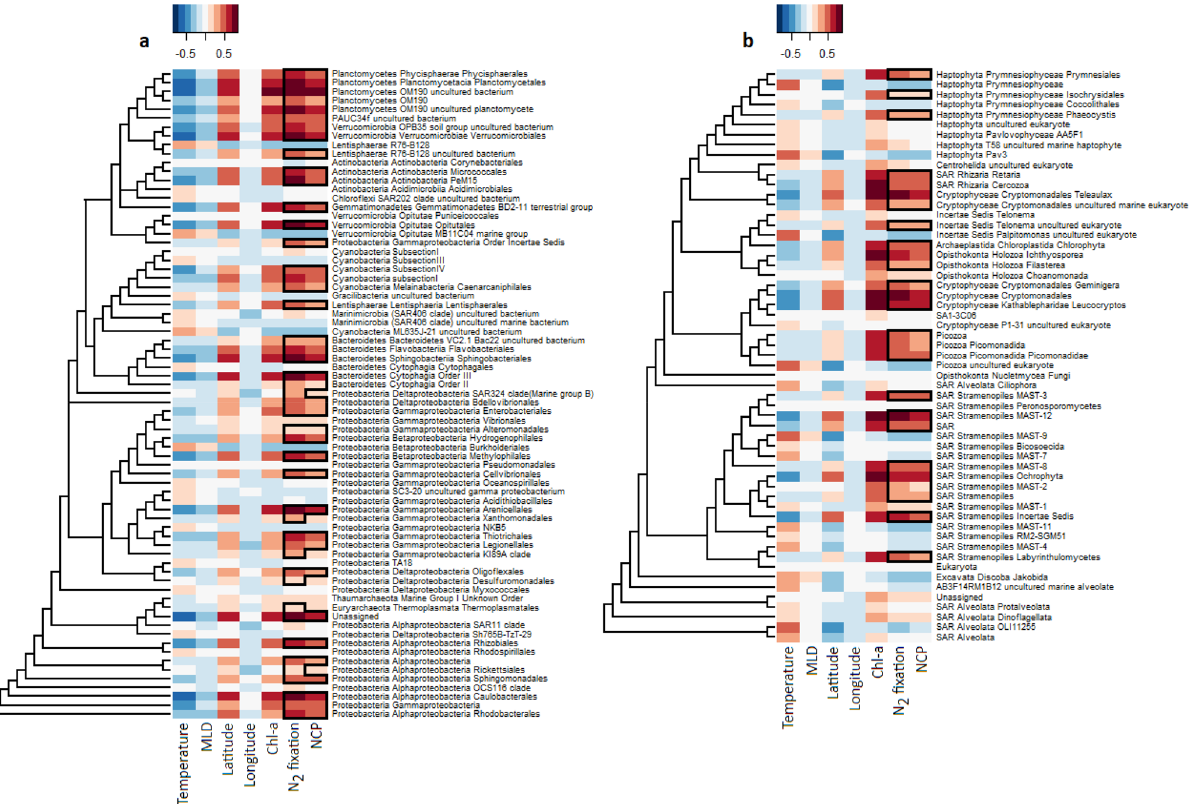
Figure 6. Heatmaps showing correlations between abundances of specific ( a) prokaryotic 16S and ( b) eukaryotic 18S taxa and measured metadata parameters for all three years of sampling, as determined using Partial Least Squares (PLS) regression analysis. The strength of correlations is illustrated by the color scale, with positive and negative correlations shown using warm and cool tones. Cells outlined in black rectangles indicate taxa with correlations to N 2 fixation or NCP greater than 0.2. Taxa are binned at the fourth taxonomic rank for both 16S and 18S data. Only taxa for which the sum of corresponding reads is more than 0.5% of the total sum of all 18S or 16S reads are displayed. Dendrograms drawn to the left of each heatmap illustrate phylogenetic relationships between row taxa. Note that horizontal branch lengths have been compressed for layout reasons and no longer represent exact distances. Figure created in R 3.5.2 (https ://www.r-proje